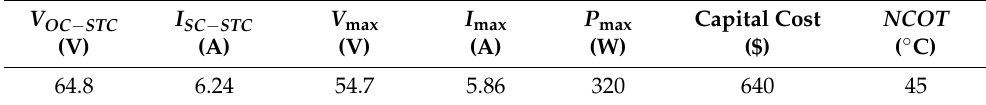
Table 2. Specification of the PV